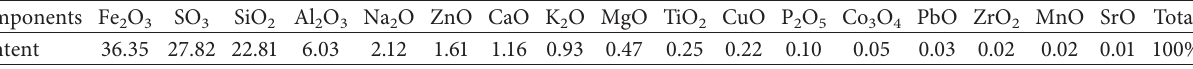
Table 1: Chemical composition of the copper tailings (wt. %).